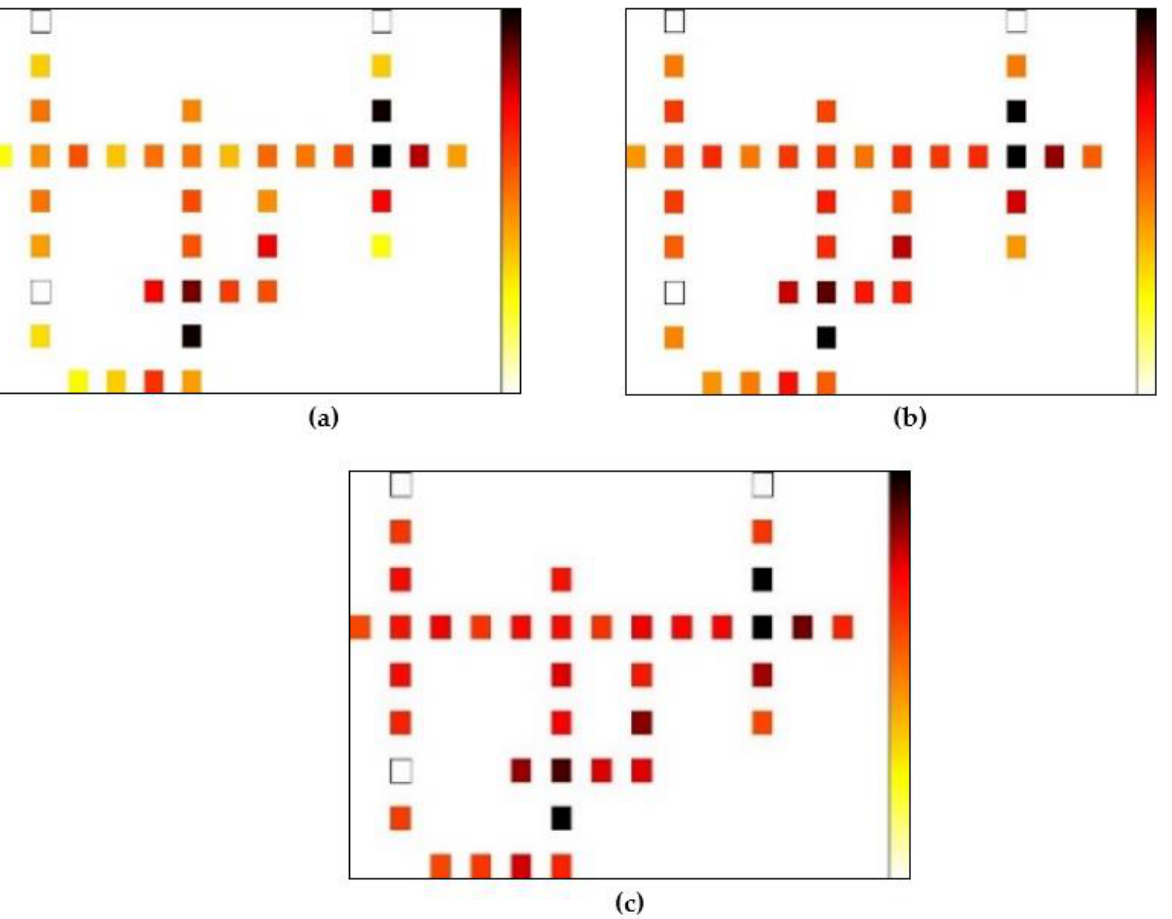
Figure 6. Energy dissipation map of the memory cell at ( a ) 0.5, ( b ) 1.0, and ( c ) 1.5 Ek levels.